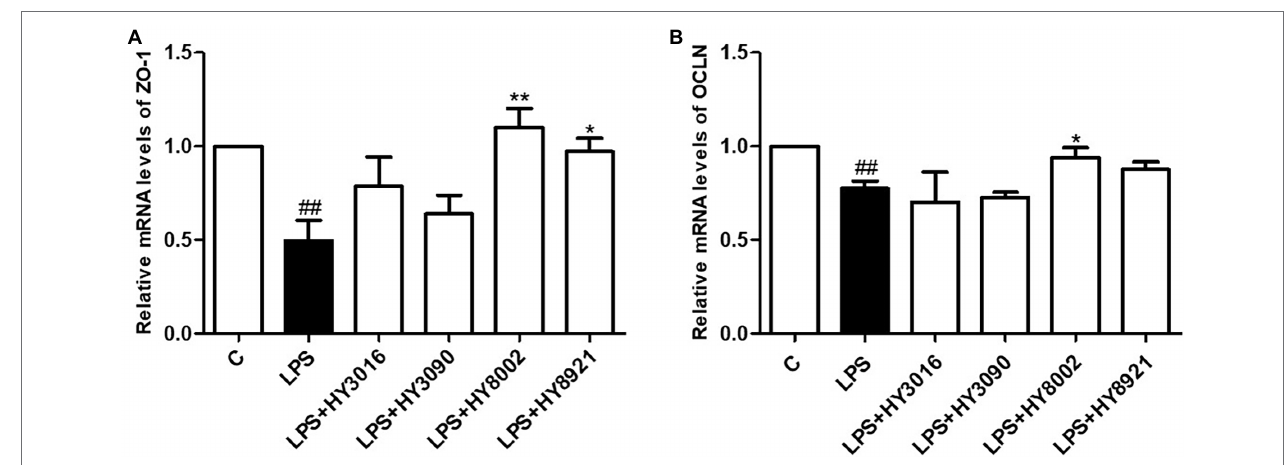
FIGURE 4 | Effect of Bifidobacterium strains on (A) zonula occludens-1 mRNA expression (B) and occludin mRNA expression in lipopolysaccharide (LPS)-treated Caco-2 cells. Each value is expressed as the mean ± SEM of three independent experiments. * p < 0.05 and ** p < 0.01 compared with LPS-treated. ## p < 0.01 compared with untreated control.